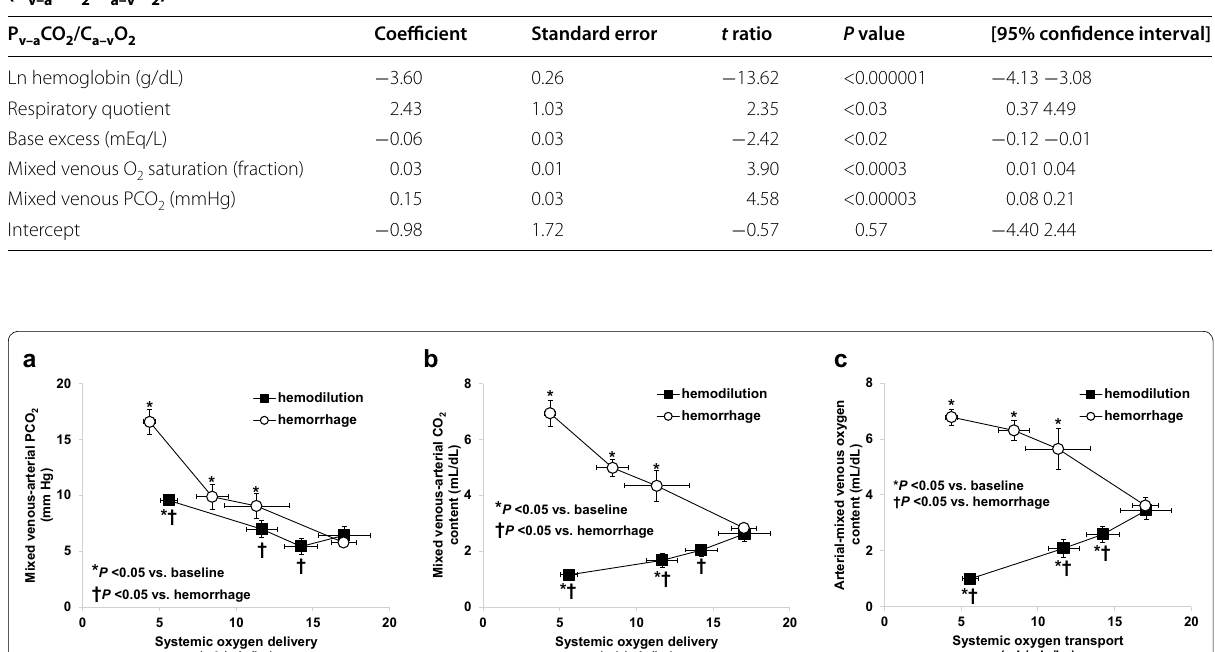
Table 1 Multiple linear regression model for the ratio of venoarterial PCO (P CO /C O ) v–a 2 a–v 2